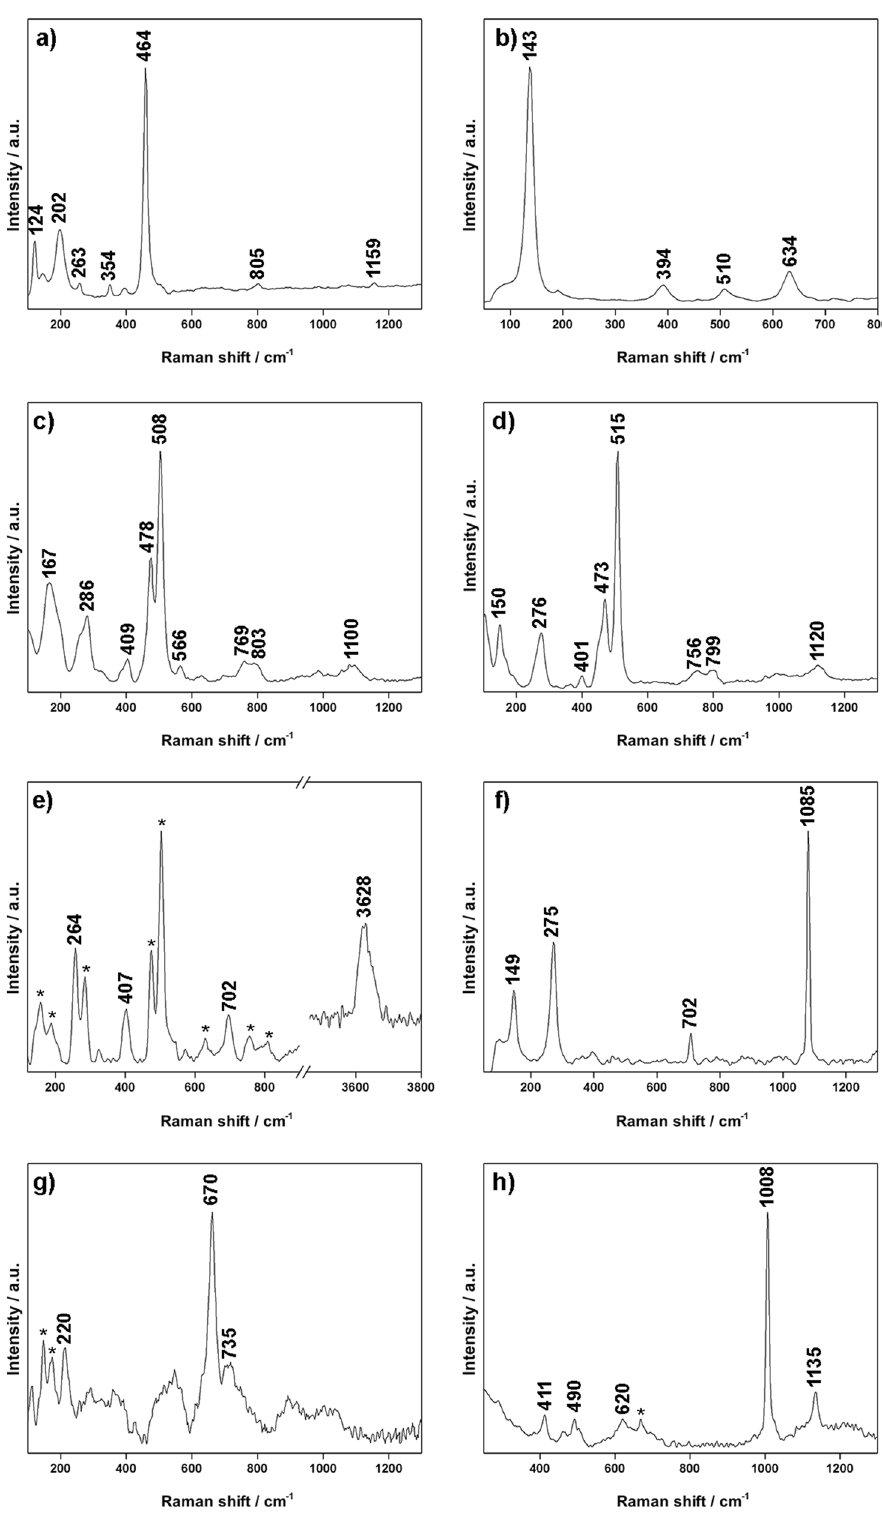
Figure 1. Characteristic Raman spectra of ( a ) quartz, ( b ) anatase, ( c ) plagioclase, ( d ) k-feldspar, ( e ) mica, ( f ) calcite, ( g ) hornblende and ( h ) gypsum, collected in the laboratory by the RLS ExoMars Simulator (532 nm). The baseline of spectra e, g and h has been corrected using dedicated IDAT/SpectPro tools. Raman signals proceeding from additional compounds are labelled with an